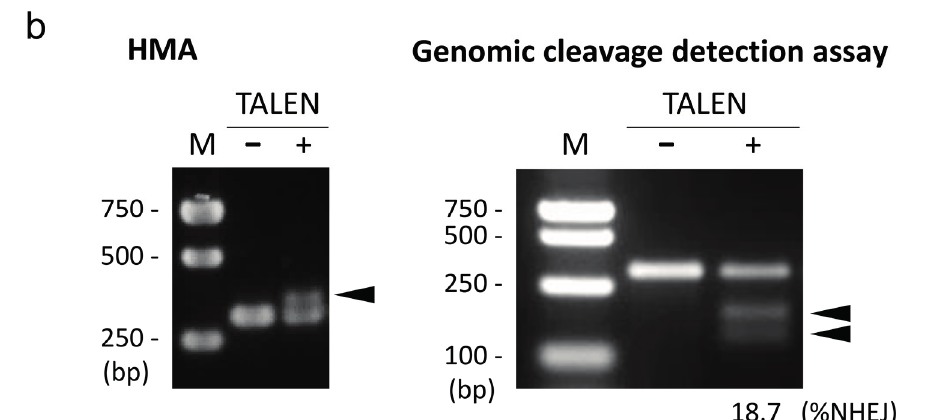
Figure 1. Design of TALEN and validation of its activity. ( a ) Schematic illustration of the TALEN target site. The genomic context was visualized using a SnapGene Viewer software (Chicago, IL, USA) (http://www.snapgene.com/), incorporating a GenBank-formatted NCBI data [19]. Solid line arrow indicates HPRT1 gene. Dash line arrow indicates HPRT1 mRNA. Red and blue letters indicate the left and right TALEN target sites,